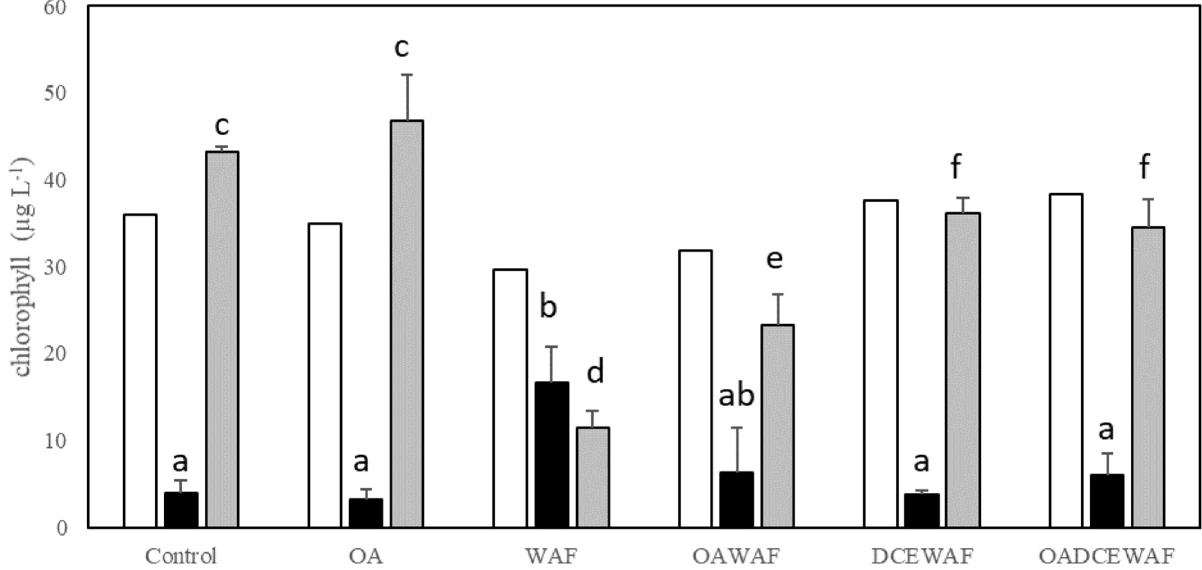
Fig 3. Chl a biomass (ug L -1 ) of T . pseudonana in the SSW at the start (white) and the end (black) of the roller table experiments, as well as the Chl a biomass in the AGG (grey bars). Error bars show standard deviation of triplicates. Different letters indicate which treatments are significantly ( p < 0.05) different from each other. https://doi.org/10.1371/journal.pone.0235473.g003 (Table 3). The final EOE concentrations were more variable, ranging from 0.08 to 0.18 mg L -1 . Oil concentrations (EOE and PAH) were the under detection limit for the Control and OA treatments. Initial PAH concentrations were higher in WAF and OAWAF (60.29 ng L -1 and 61.27 ng L -1 , respectively) than in DCEWAF and OADCEWAF (2.56 ng L -1 and 2.75 ng L -1 , respec- tively). The concentrations of PAHs incorporated into AGG at the end of the roller table